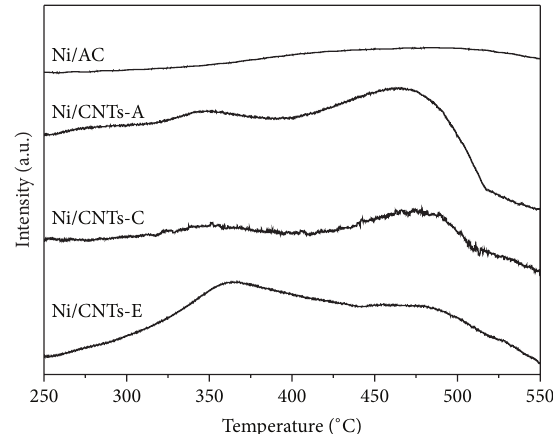
Figure 5: H 2 -TPR profiles of the catalysts prepared with different supports.